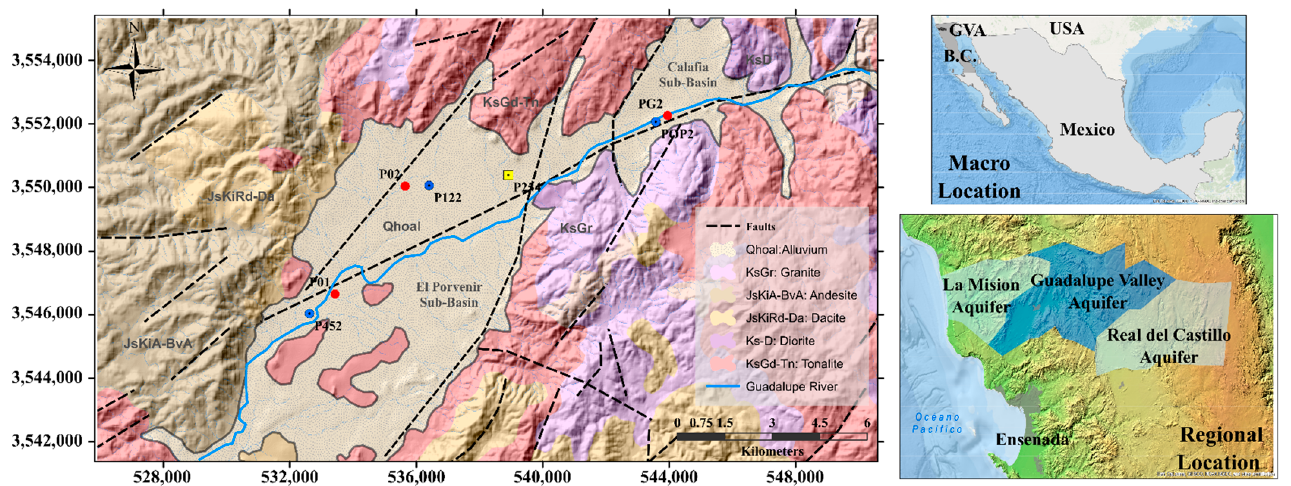
Figure 1. Macro and regional location of the Guadalupe Valley Aquifer. Monitoring wells (P452, P122, and POP2) instrumented are shown. Reference wells (P01, P02, and PG02) included as a part of the study (lithology column availability) are shown. The location of the barometer (P254) is also shown. Geological features are illustrated and described at inset legend [35,36].